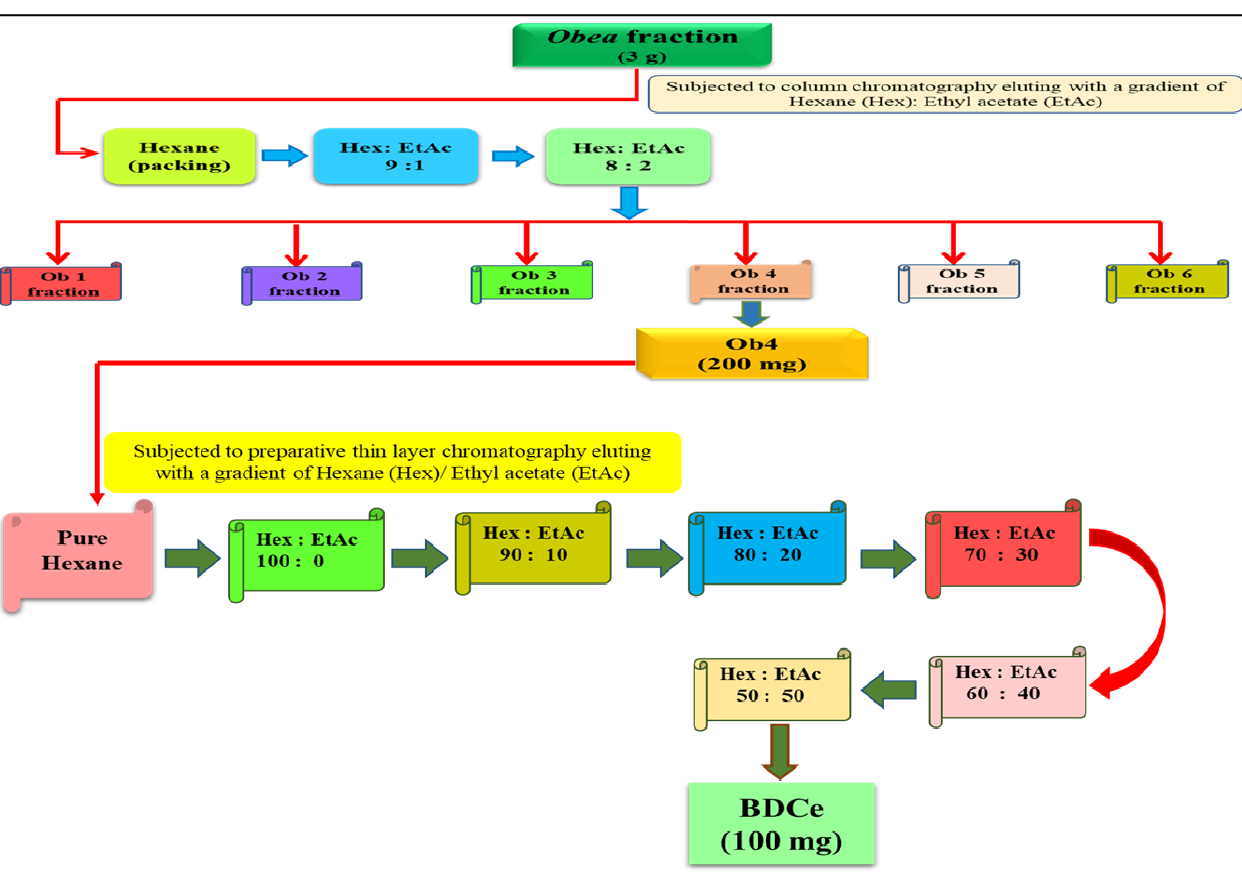
Figure 18. Schematic representation of BDCe fraction isolation from O. bracteata using column chro- matography.